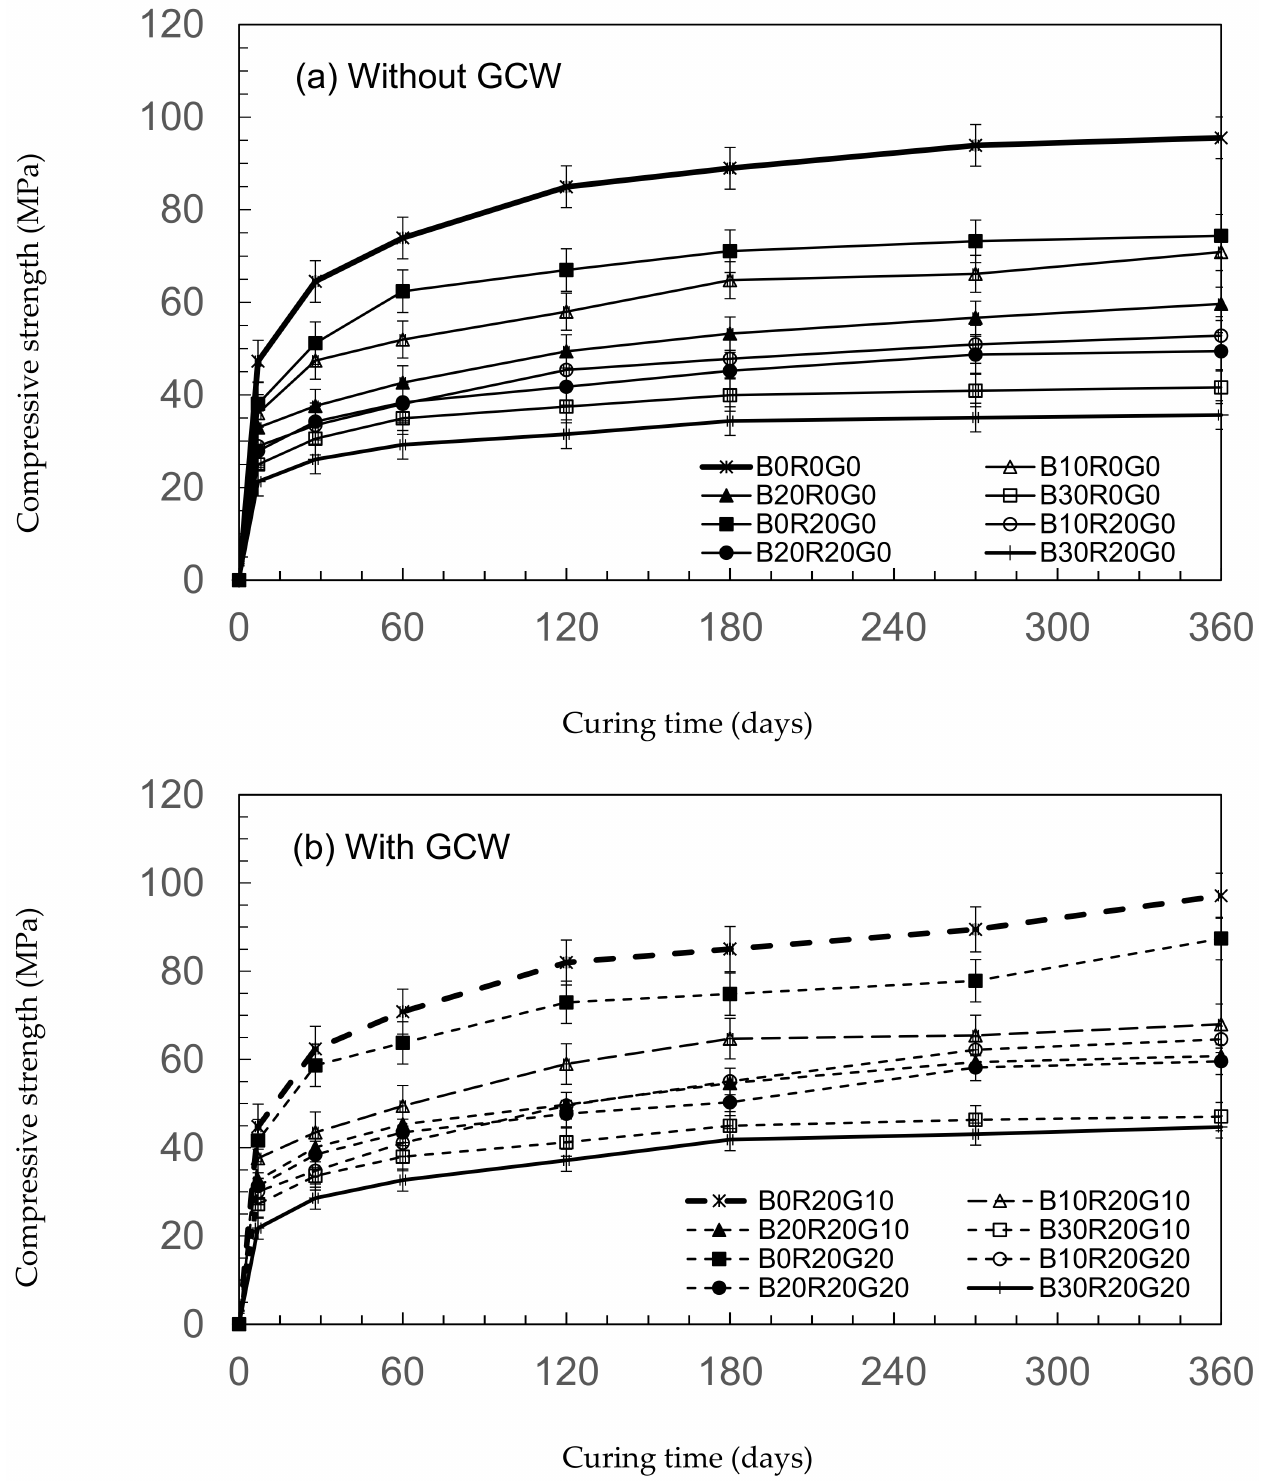
Figure 2. Compressive strengths of gSCC. ( a ) without GCW and ( b ) with